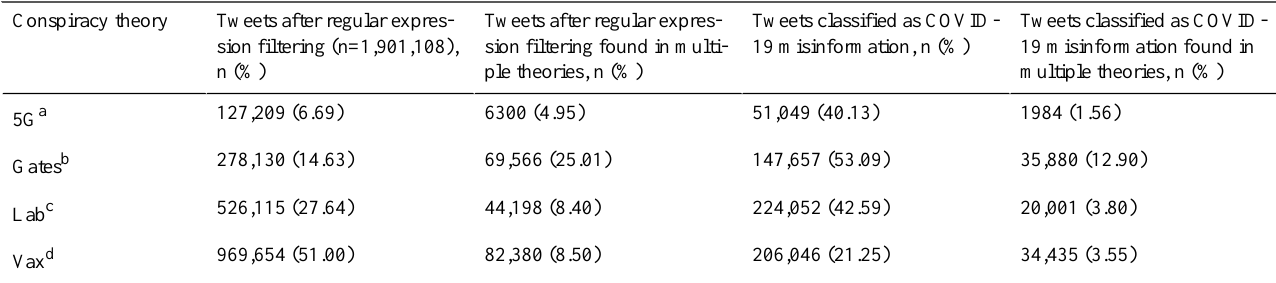
Table 2. Results of the regular expression filtering step. After filtering using regular expressions on tweets spanning January 21 to May 8, 2020, the number of tweets per conspiracy theory and the number of tweets that were included in multiple theories are shown. The number of tweets within each filtered data set that were later classified as COVID-19 misinformation and the number of classified tweets that appear in multiple theories are also